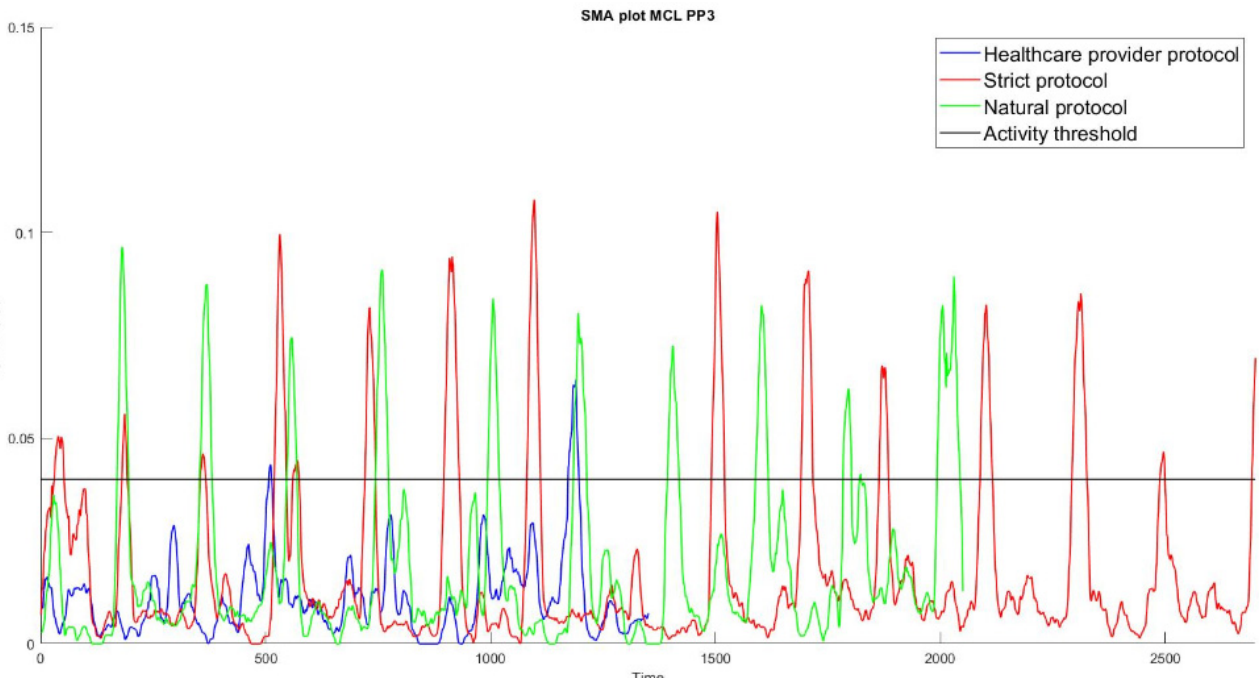
Figure 2. Signal magnitude area (SMA) of one participant during the performance of activities of three protocols (natural, green; healthcare provider, blue; and strict, red). The black line is used to determine the cut-off point to identify dynamic activities during the development of the algorithm. Note that the SMA value in the healthcare provider protocol (blue) is much lower compared to the other